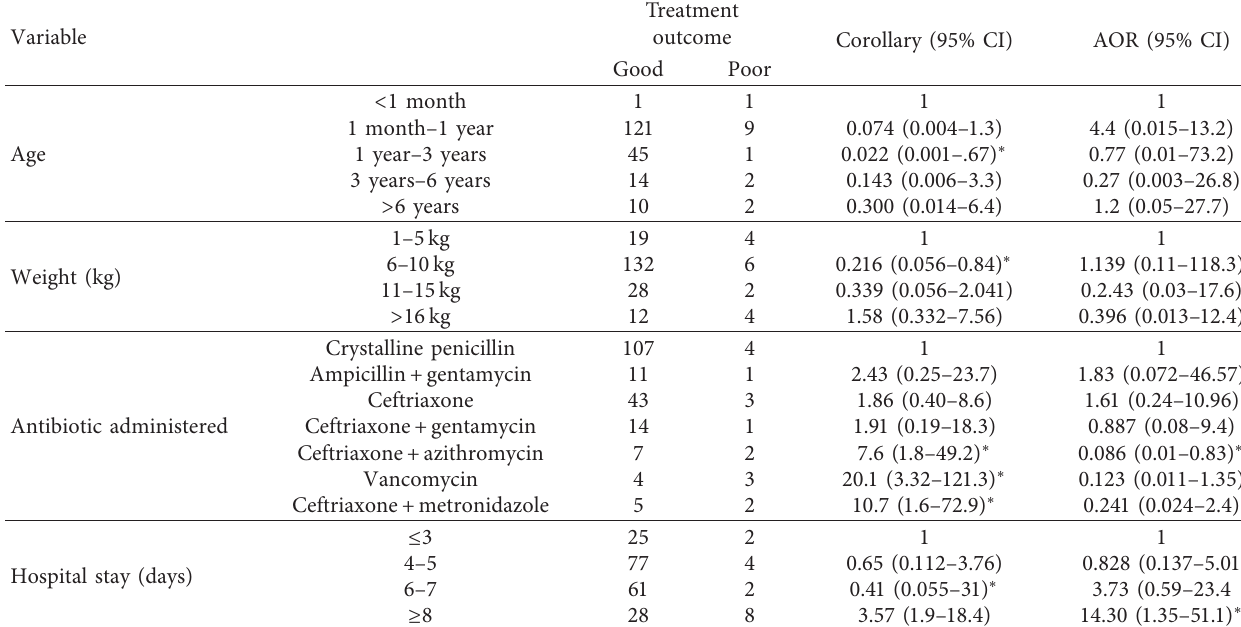
Table 4: Predictors of treatment outcomes among children treated for pneumonia at the pediatric ward of Tikur Anbessa Specialized Hospital from February 2017 to February 2018, Addis Ababa, Ethiopia.